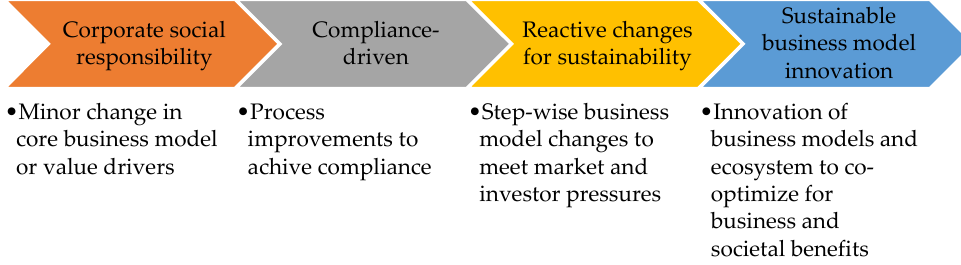
Figure 3. From compliance to sustainable competitive advantage. Source: Young and Reeves (2020) .